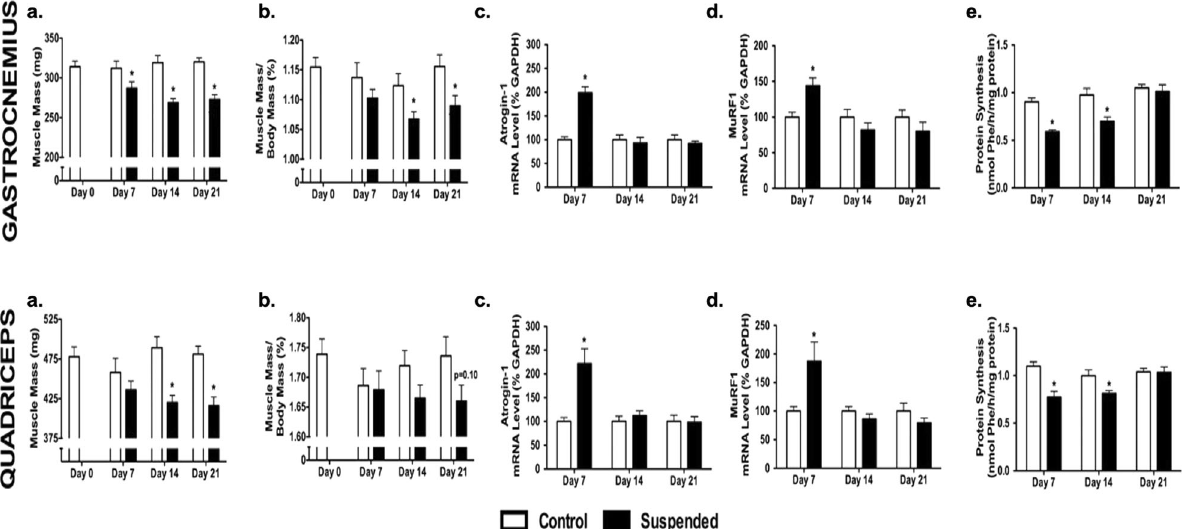
Fig. 3 Skeletal muscle properties obtained from mice subjected to normal loading (Control) or mechanical unloading via hindlimb suspension (Suspended). a Total muscle mass, b muscle mass normalized to body mass, c mRNA levels of the gene encoding atrogin ‐ 1, d mRNA levels of the gene encoding Murf1, and ( e ) protein synthesis rates were determined for both the gastrocnemius (top) and quadriceps (bottom). ( n = 12 –